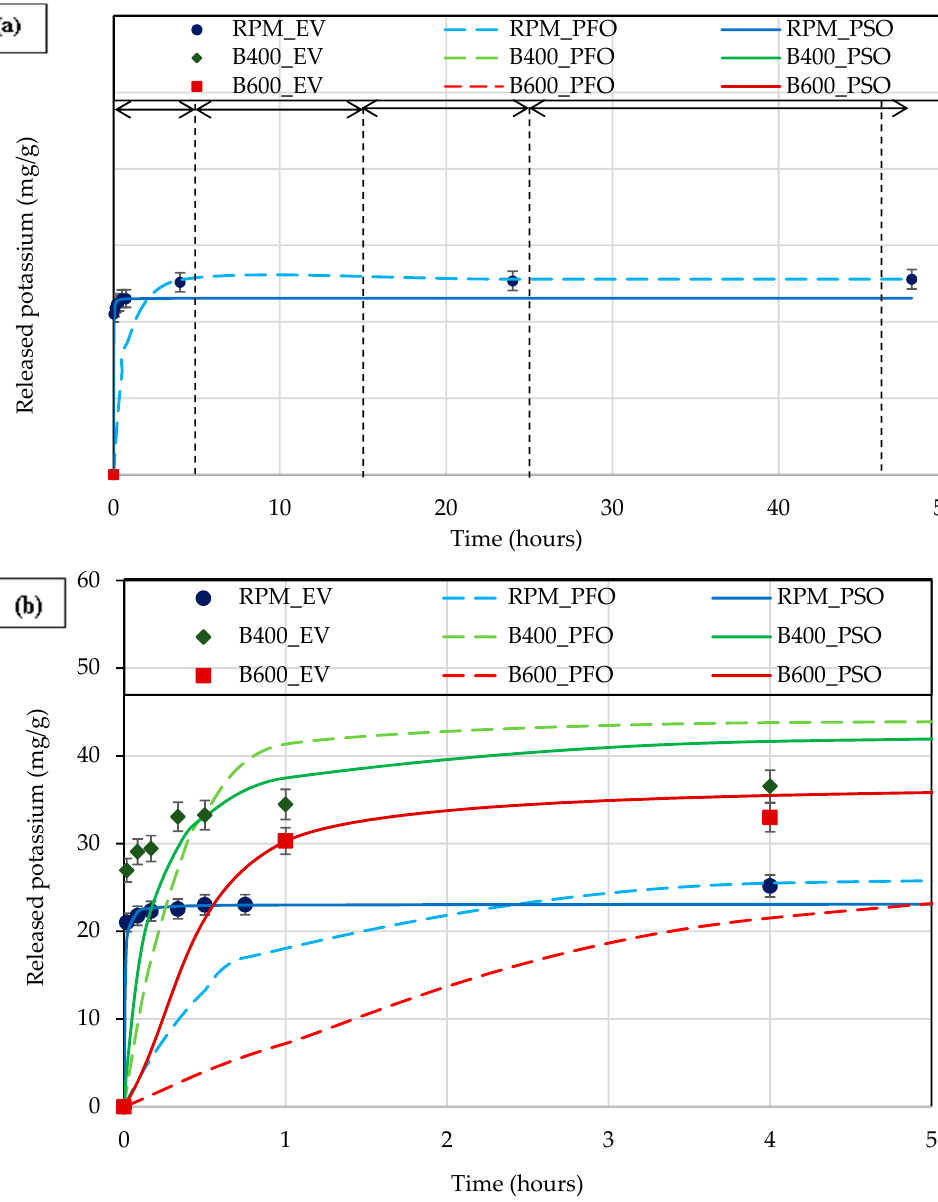
Figure 3. Comparison between the experimental and theoretical quantities of potassium released by raw poultry manure (RPM) and its derived biochars (EV: Experimental values; PFO: pseudo-first order; PSO: pseudo-second order) for 48 h ( a ) and zoom for 5 h ( b ).